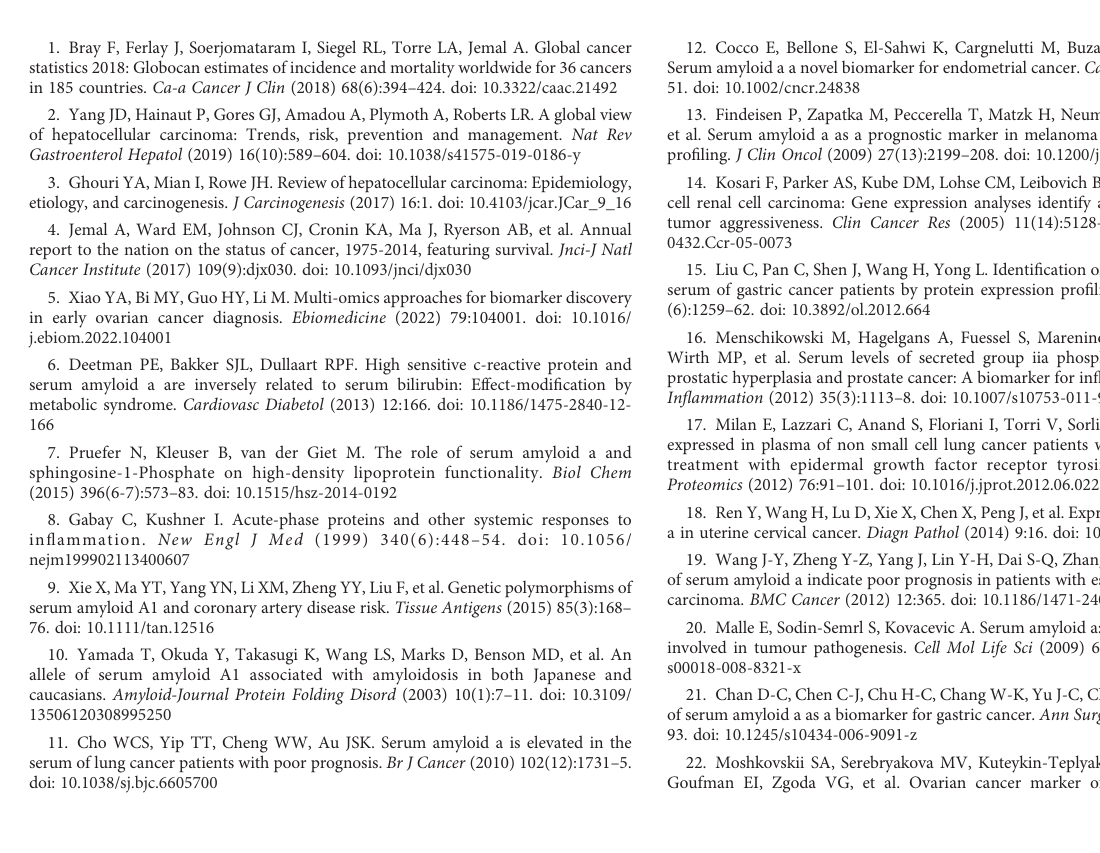
SUPPLEMENTARY FIGURE 1 Schematic fl ow of transcriptomic sequencing. SUPPLEMENTARY FIGURE 2 Flow chart of iTRAQ-MALDI-MS/MS